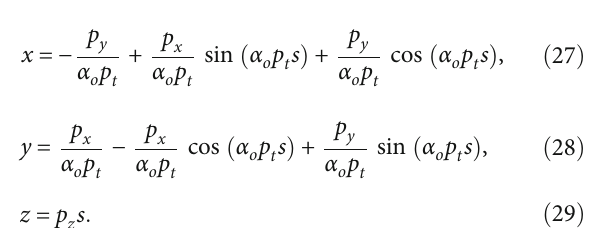
Figure 1: Four light rays in the ̂ x – ̂ y plane for p The large circle is a reference circle with a radius of 2/ α spatial part of each of the four light rays forms closed loops. Rays = − 1 (solid black on the right), p for p y = 0 with v < 0 (dashed, below ̂ x axis), and p left), p xo y > 0 (dashed, above the ̂ x axis) are